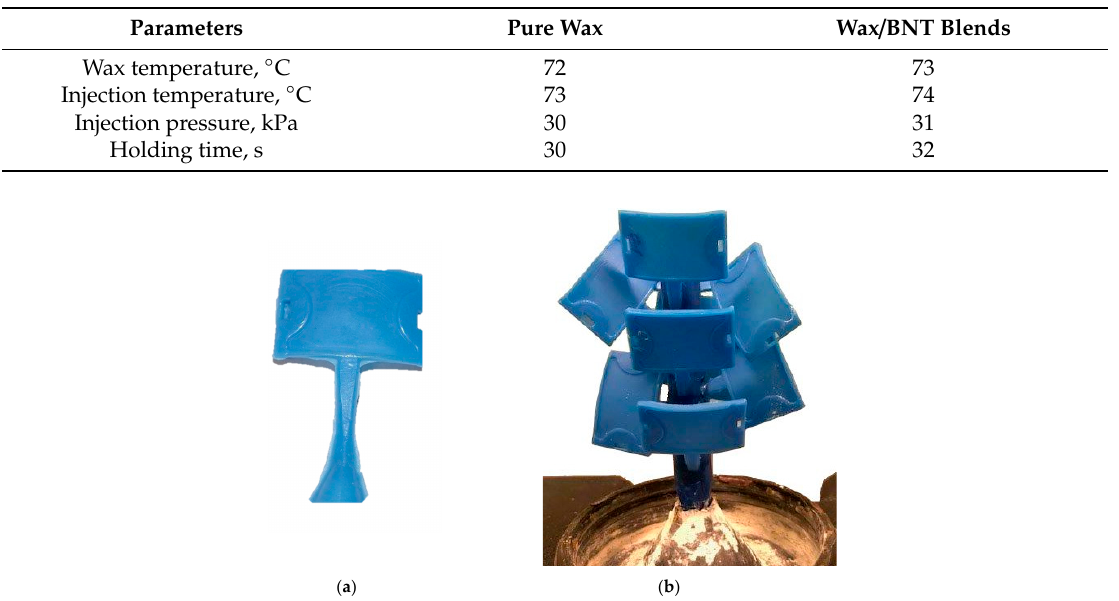
Figure 6. The smelting process and heat treatment (annealing) of the gypsum mold.